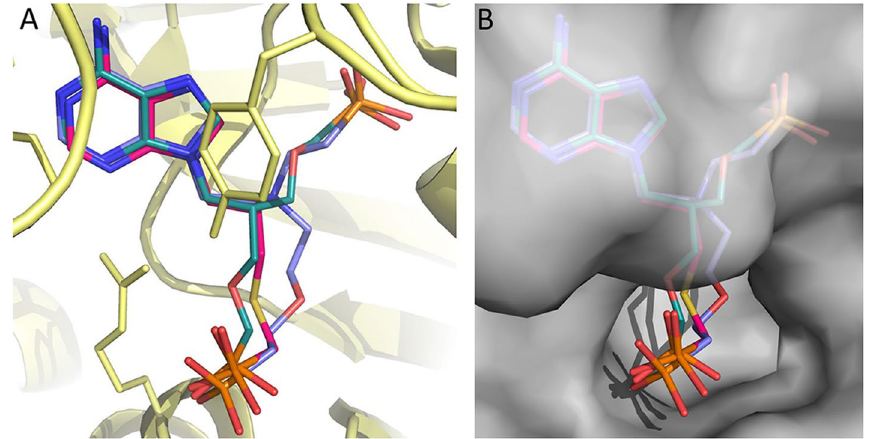
Figure 6. Superimposition of three docked ANPs in the T. brucei APRT1 structure (PDB code 5VN4). ( A ) 3a (red), 9g (violet) and 22 (green) shown as stick models and the polypeptide as ribbon structure with the amino acid side chains as sticks. ( B ) The transparent Connolly surface of the enzyme with 3a , 9g and 22 show as stick models. Images were drawn using PyMOL 2.4 49